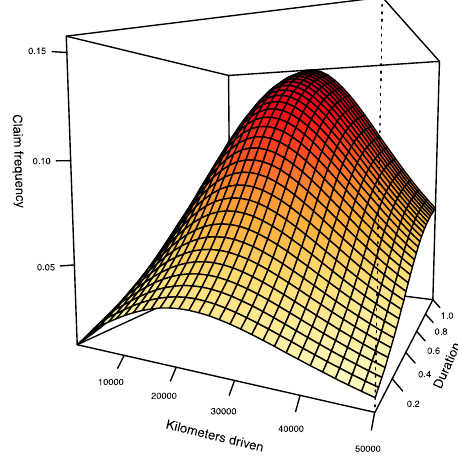
Figure 9. Model 1—Predictions surface (angle 2).